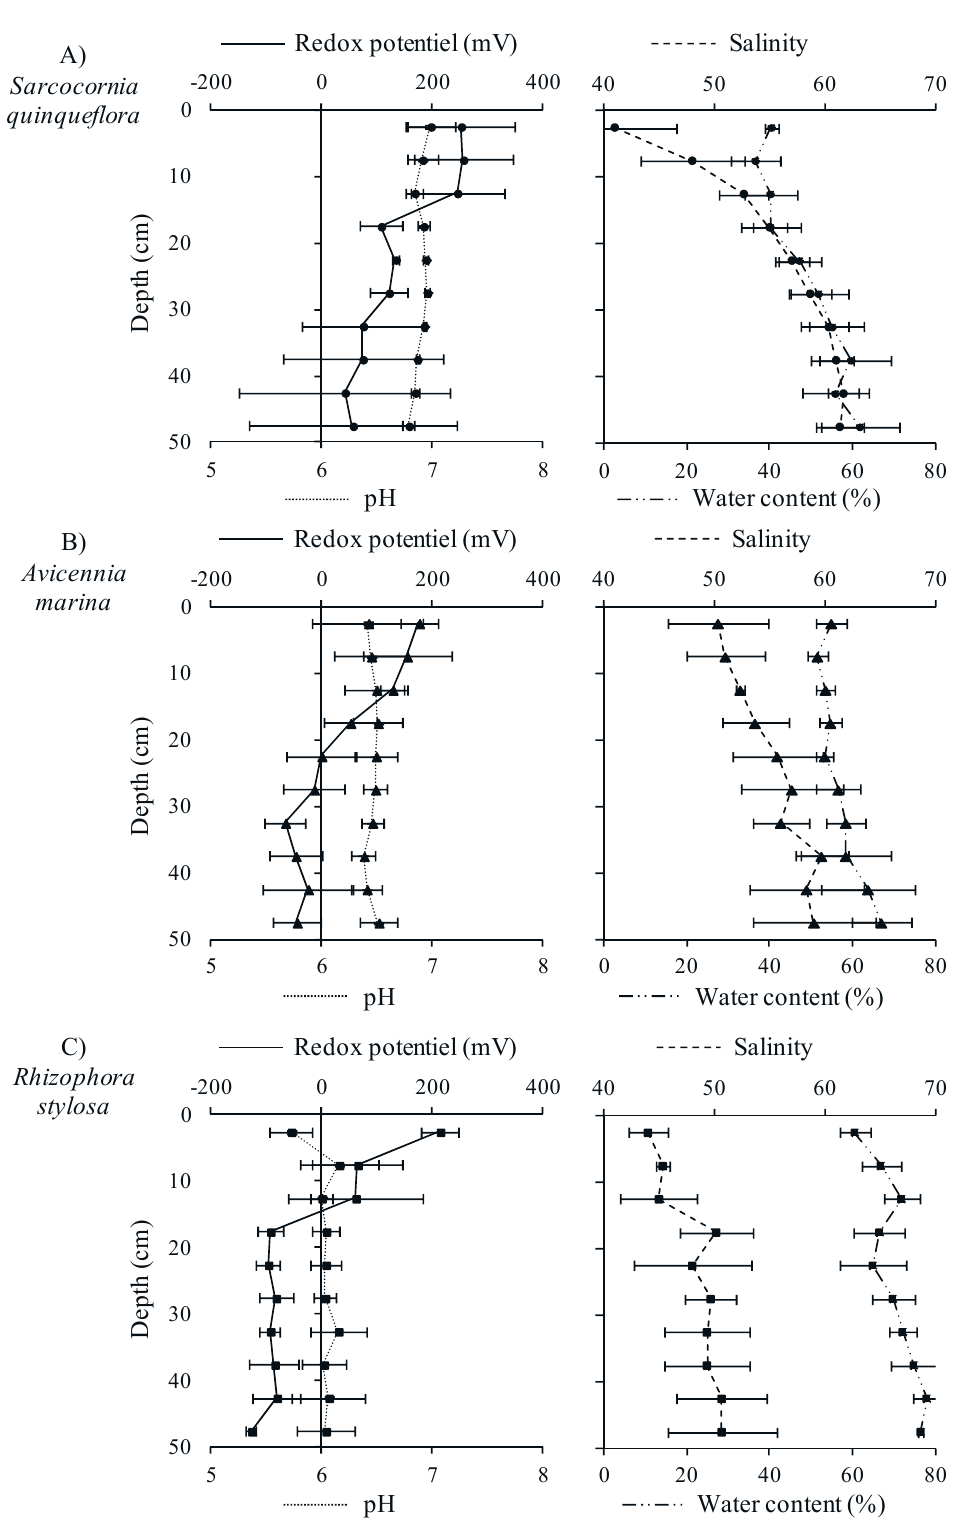
Figure 2. Mean values ( n = 3) and standard deviation of redox potential, pH, salinity and water content measured in the sediment from surface to 50 cm depth of the three mangrove vegetation